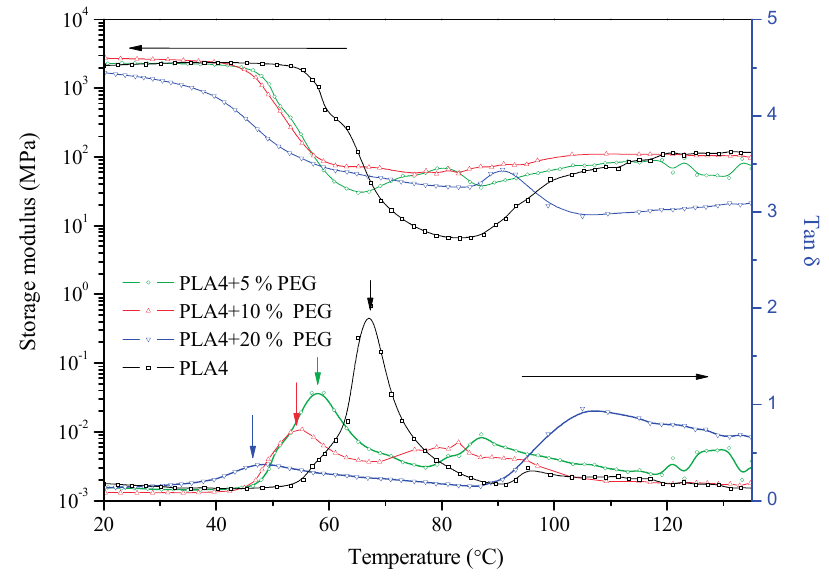
Figure 5. Temperature dependence of the storage modulus and tan δ of PLA4 binary composites with